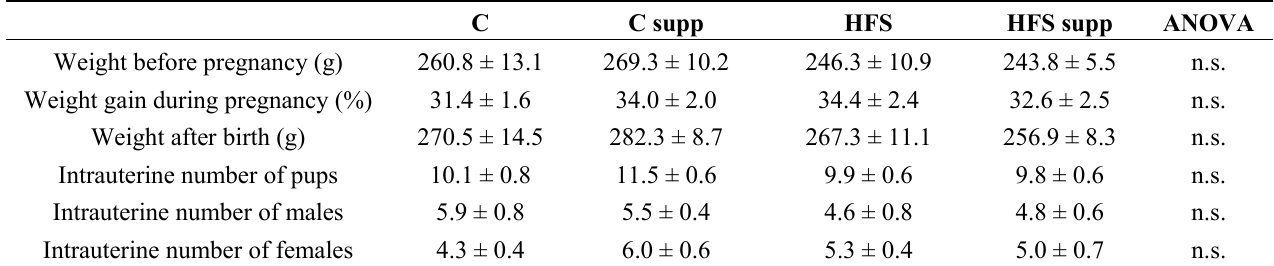
Table 1. Maternal perinatal